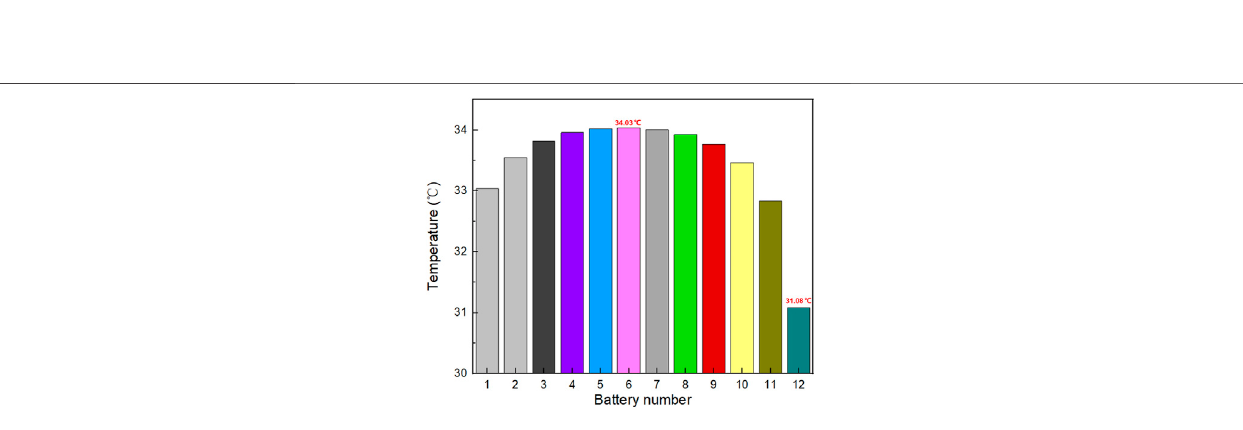
FIGURE 6 | Temperature development of the BTMS at different discharge rates.